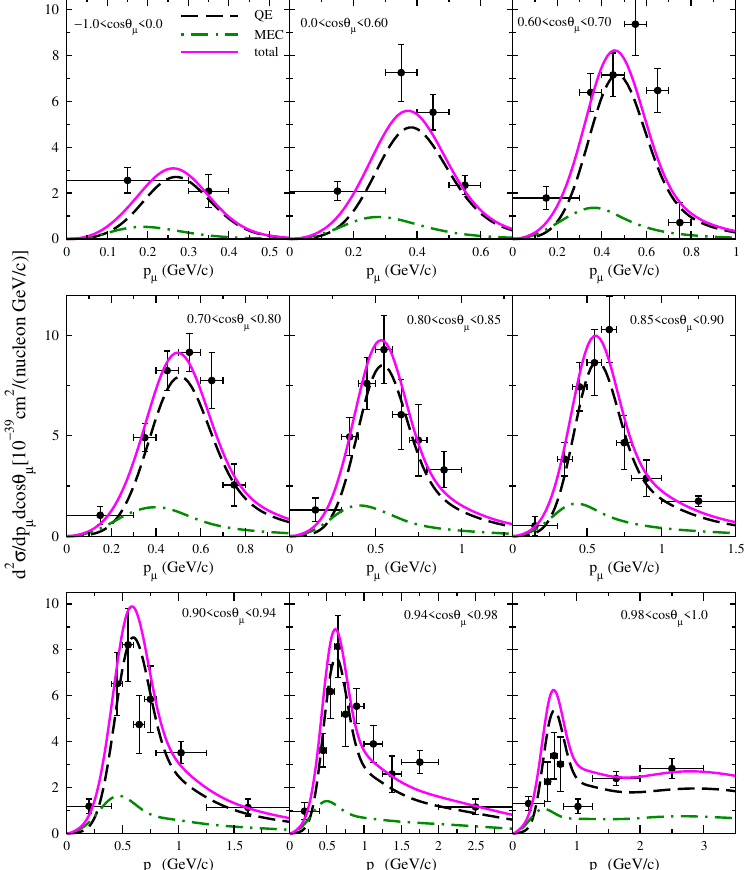
Figure 4. The SuSA double differential ( ν µ , µ − ) cross-section off 12 C with no pions in the final state, averaged over the T2K flux, is displayed versus the muon momentum p µ . The separate QE and MEC contributions are also shown. The data correspond to Analysis 1 from Ref.